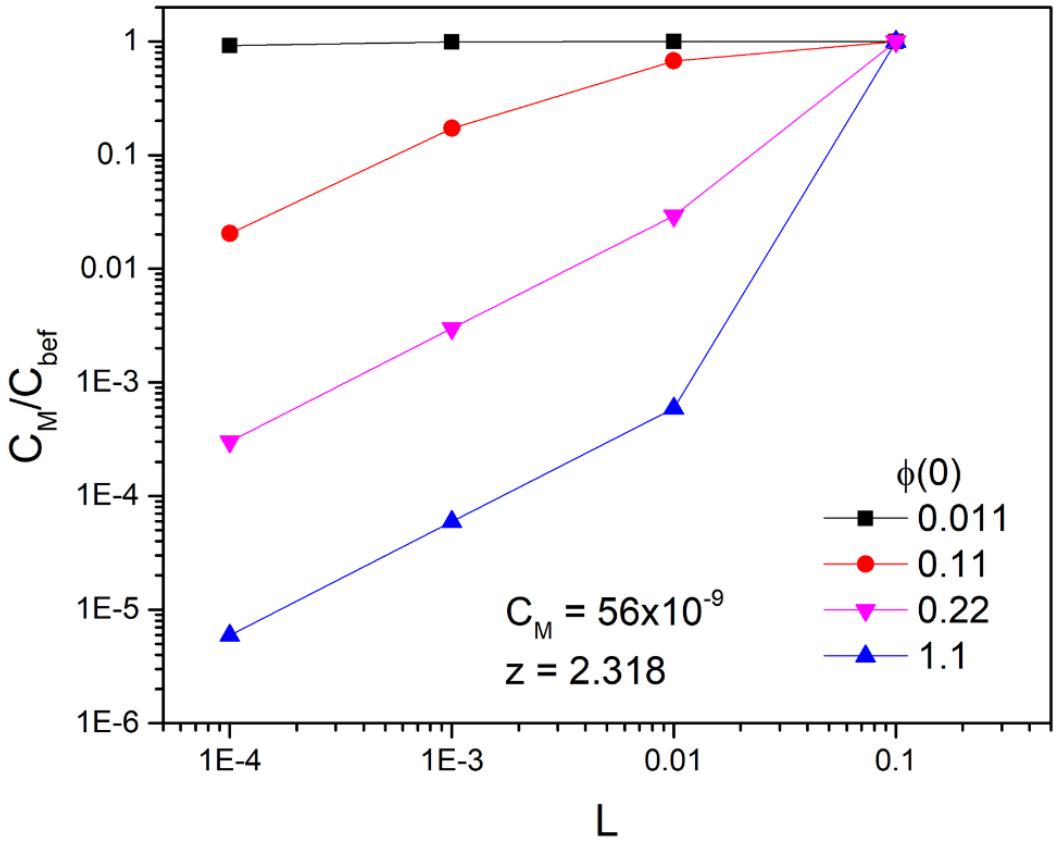
Figure 7. C M as a function of L (m) for toxin 1, concentration C M = 56 × 10 − 9 mol (cid:3004) (cid:3262) C bef Figure 7. as a function of L (m) for toxin 1, concentration 𝐶 (cid:3014) = 56 × 10 (cid:2879)(cid:2877) (cid:3004) (cid:3277)(cid:3280)(cid:3281) potentials ϕ ( 0 ) potentials 𝜑(0) (V).